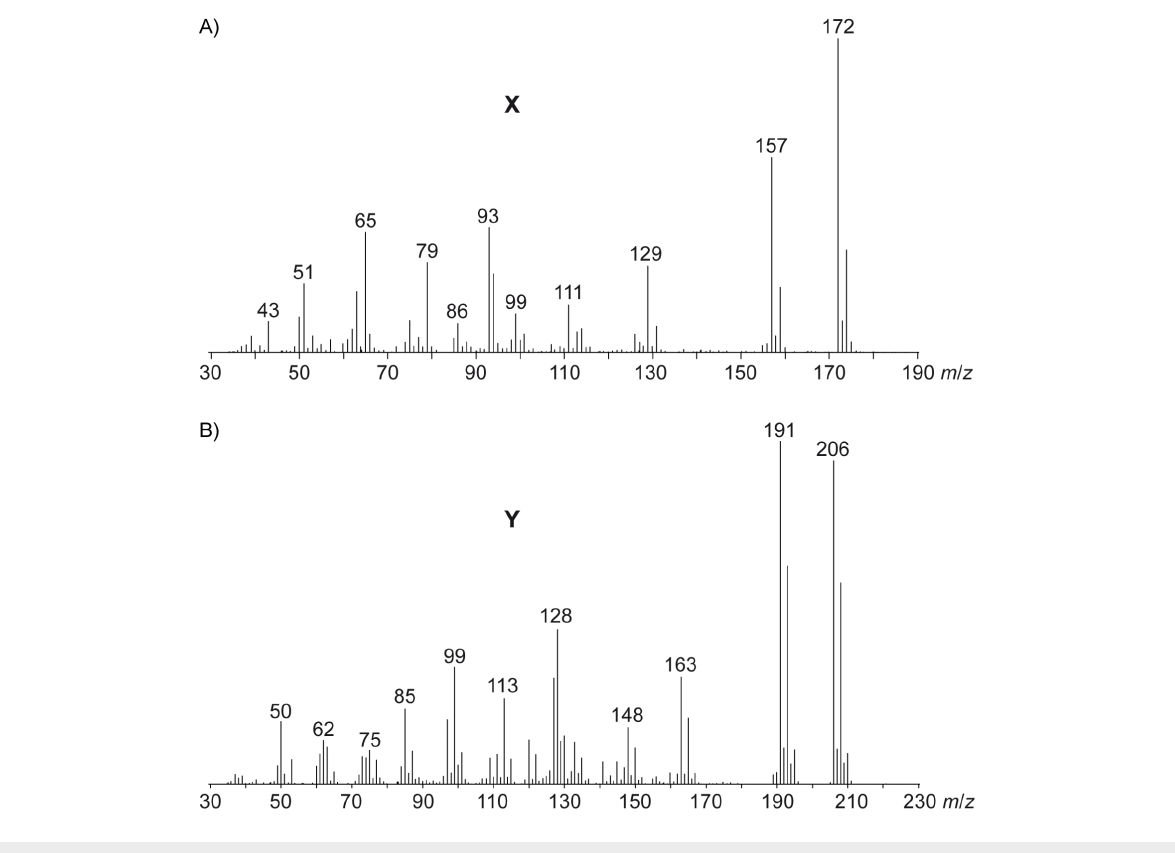
retention indices of both natural products to authentic standards of all possible structural isomers was pursued.